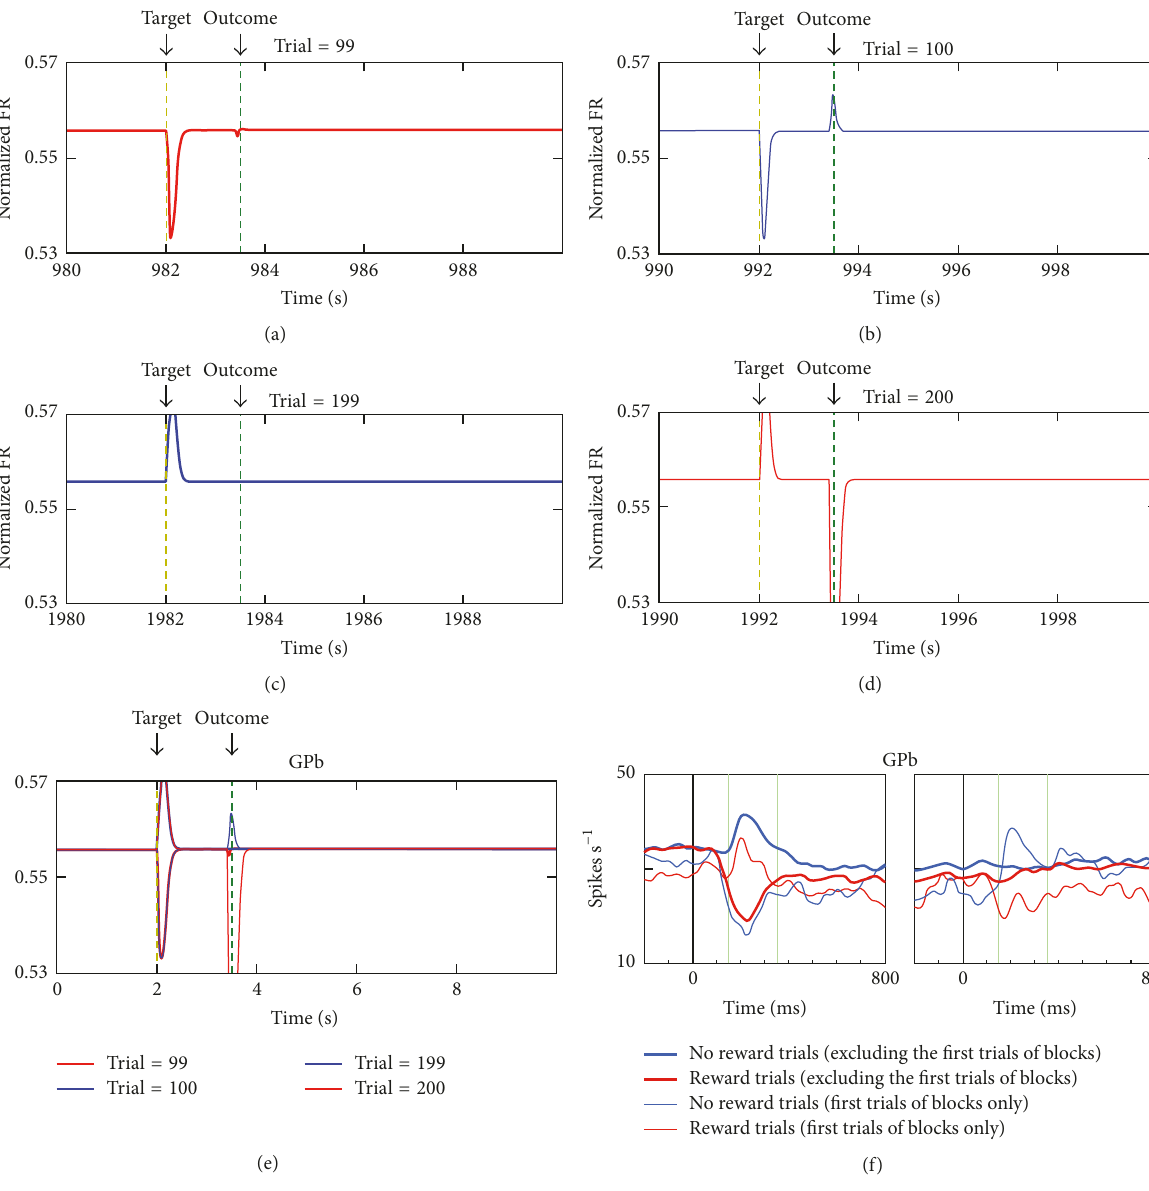
Figure 7: Acquired response of GPb neurons. (a) ∼ (e) Similar to Figure 6. (f) The physiological experimental result reprinted from Hong and Hikosaka